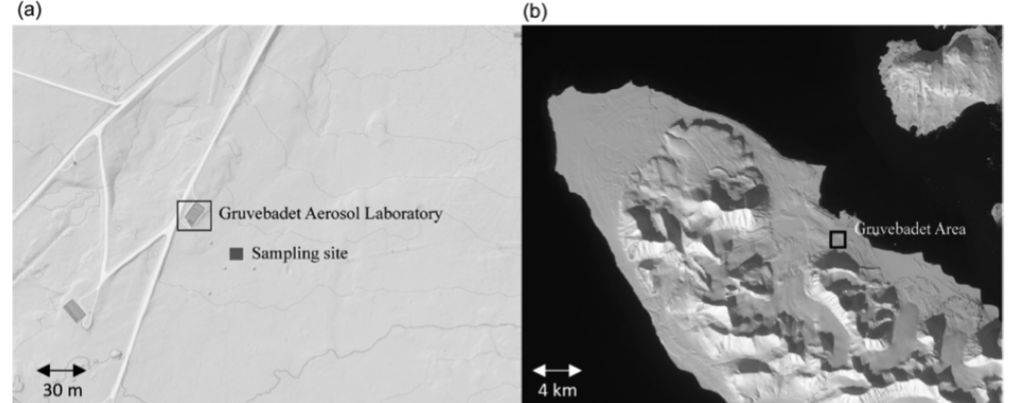
Figure 1. (a) Experimental sampling site location (dark gray rectangle) in the proximity of the Gruvebadet Aerosol Laboratory. (b) Gru- vebadet area (black square) close to the Ny-Ålesund research village. Source: Spolaor et al. (2019); maps from https://toposvalbard.npolar. no/(last access: 15 July 2021). The red arrow points to the